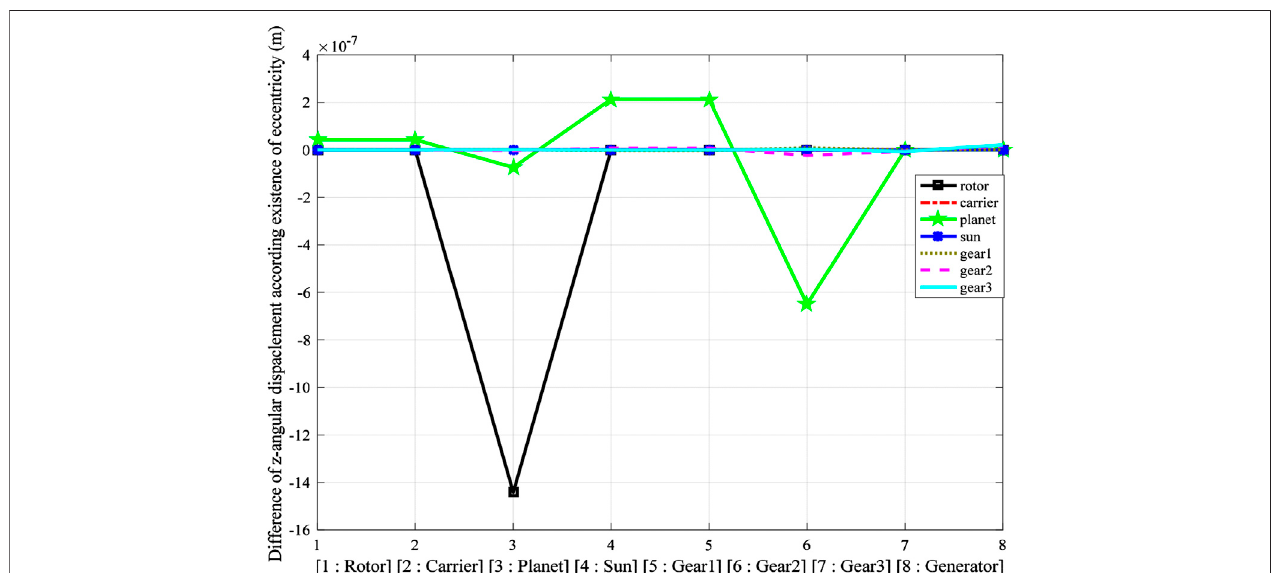
FIGURE 10 | Eccentricity influence on the angular displacement of each component.